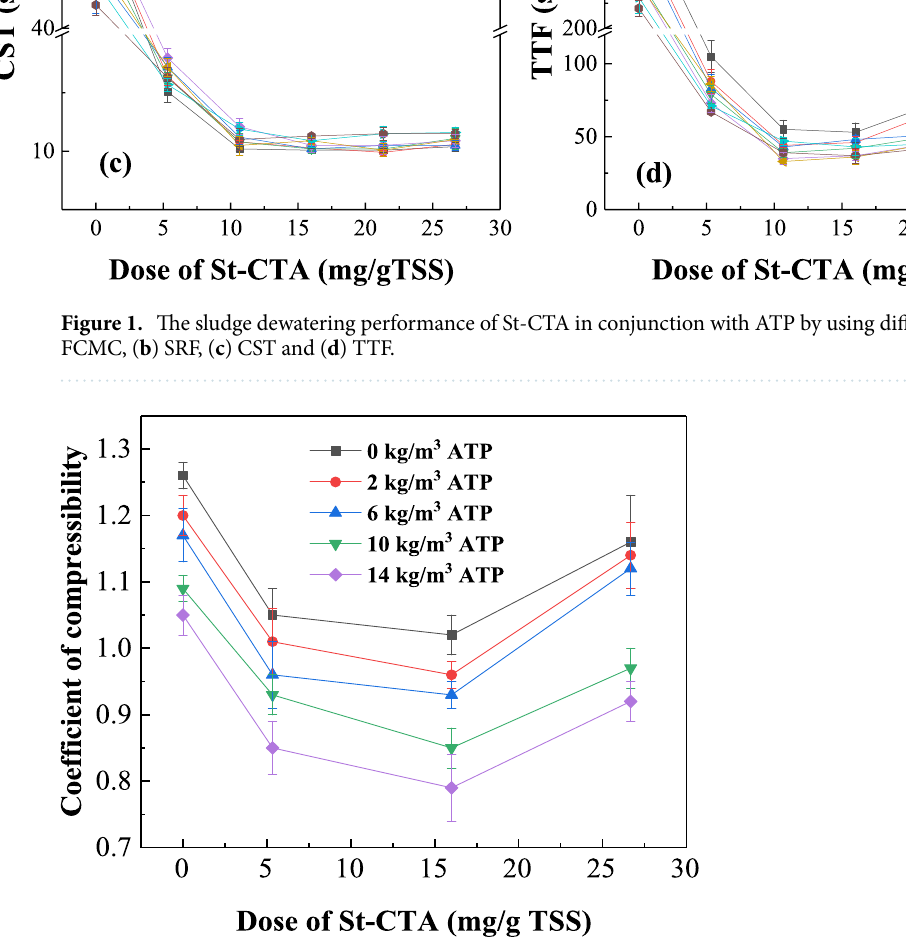
Figure 2. The compressibility coefficients of sludge conditioned by St-CTA in conjunction with ATP using different